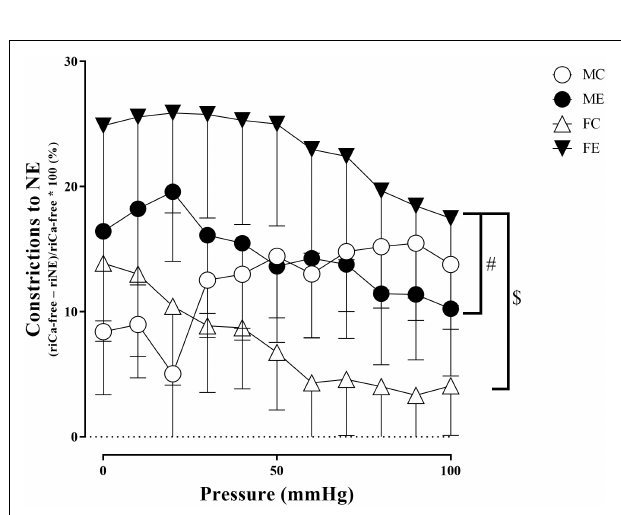
FIGURE 6 | Constrictions to NE (relative difference of the maximally relaxed and maximally contracted radius) as a function of intraluminal pressure measured in passive conditions of the gracilis muscle arterioles from the MC, ME, FC, and FE animals. As a result of norepinephrine, the constriction was significantly higher in the FE rats compared with the FC and ME rats. The data are expressed as the mean (SEM) values. The significance levels of the two-way ANOVA and Tukey’s post hoc tests between the four groups are shown. $ P < 0.05 FC vs. FE and # P < 0.05 ME vs. FE.